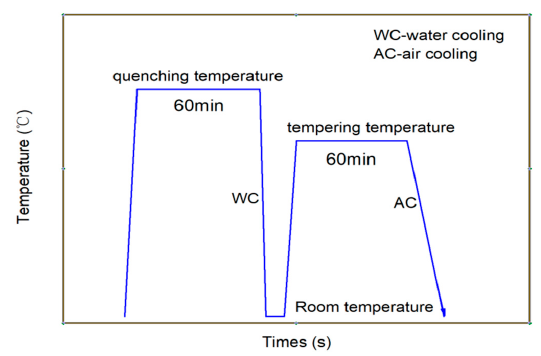
Figure 1. Schematic drawing of the heat treatment routes of the experimental casing steel .